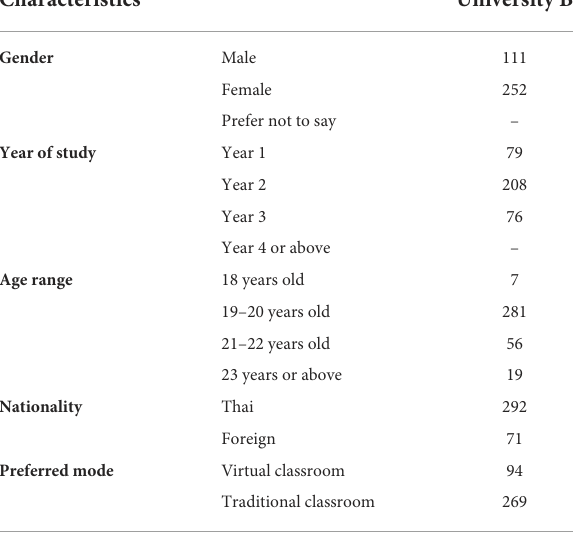
TABLE 2 Sample from Khon Kaen University in Khon Kaen, Thailand.